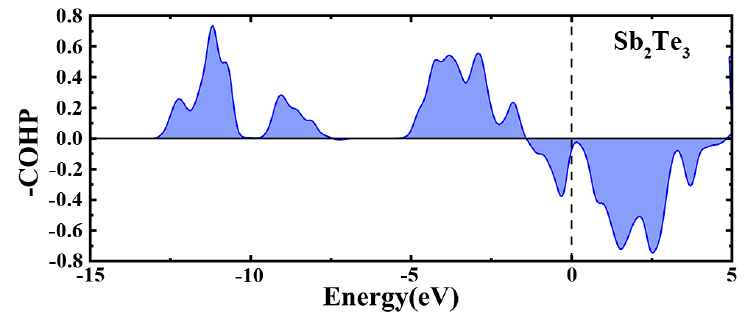
Figure 4. An XRD diagram of Sb 2 Te 3 and C-Sb 2 Te 3 in the experiment. ( a ) Sb 2 Te 3 ; ( b ) C 20W Sb 2 Te 3 ; and